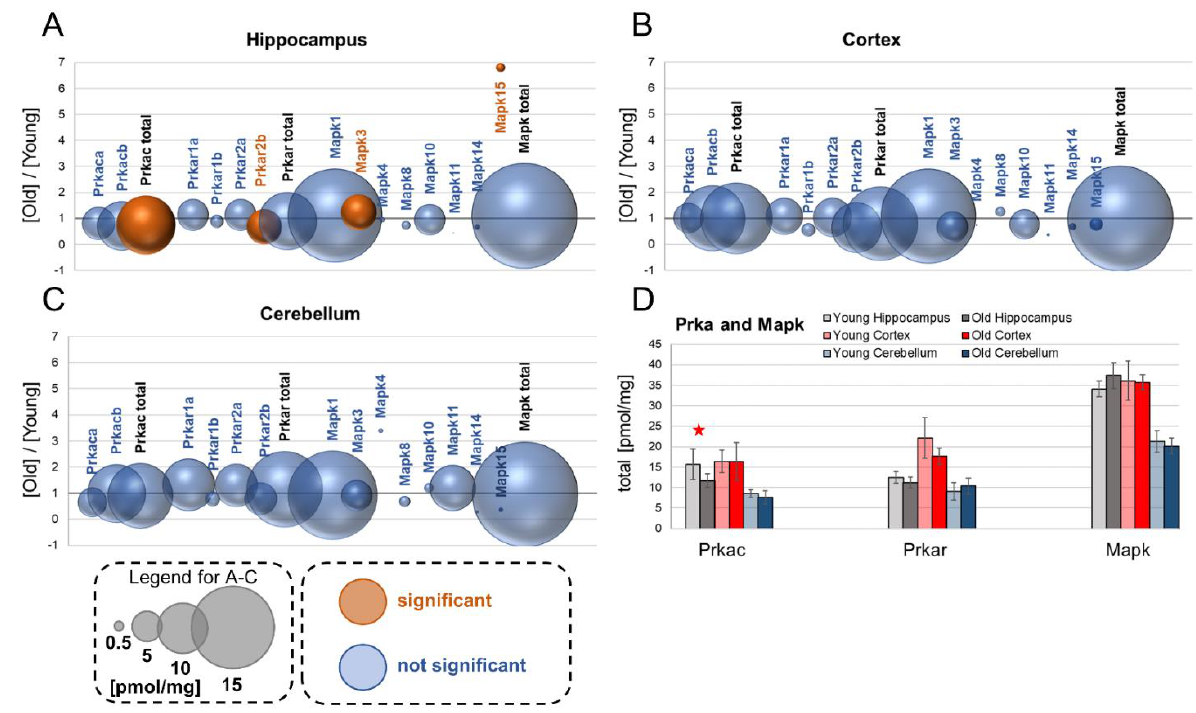
Figure 4. Aging-related changes in PKA (Prka) and Map kinases. The ratios of the kinase concentrations in old vs. young brain formations in: hippocampus ( A ), cortex ( B ) and cerebellum ( C ). Total concentrations of the kinase families in young and old animals are shown in ( D ) (* p < 0.05). The size of bubbles is proportional to the average protein concentration in the respective old brain structures. Statistically significant differences are shown as the red bubbles.